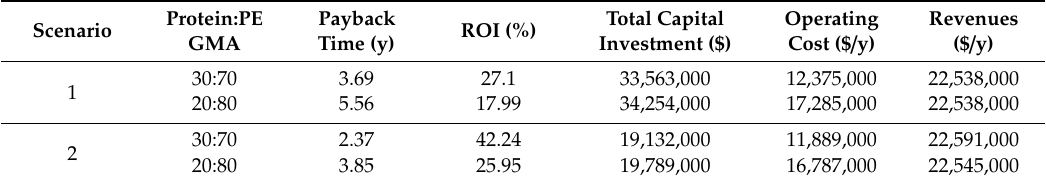
Table 3. Economic e ff ects of di ff erent protein / poly(ethylene glycol) methyl ether methacrylate